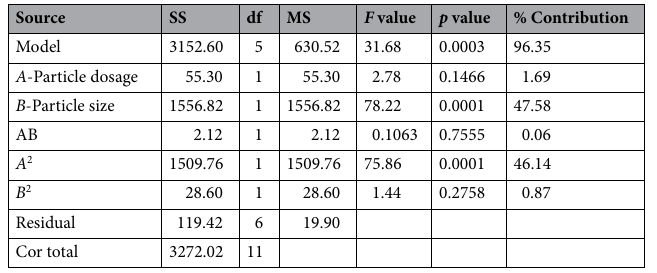
Table 5. ANOVA result on flexural strength (FS). SS sum of squares, MS mean square.